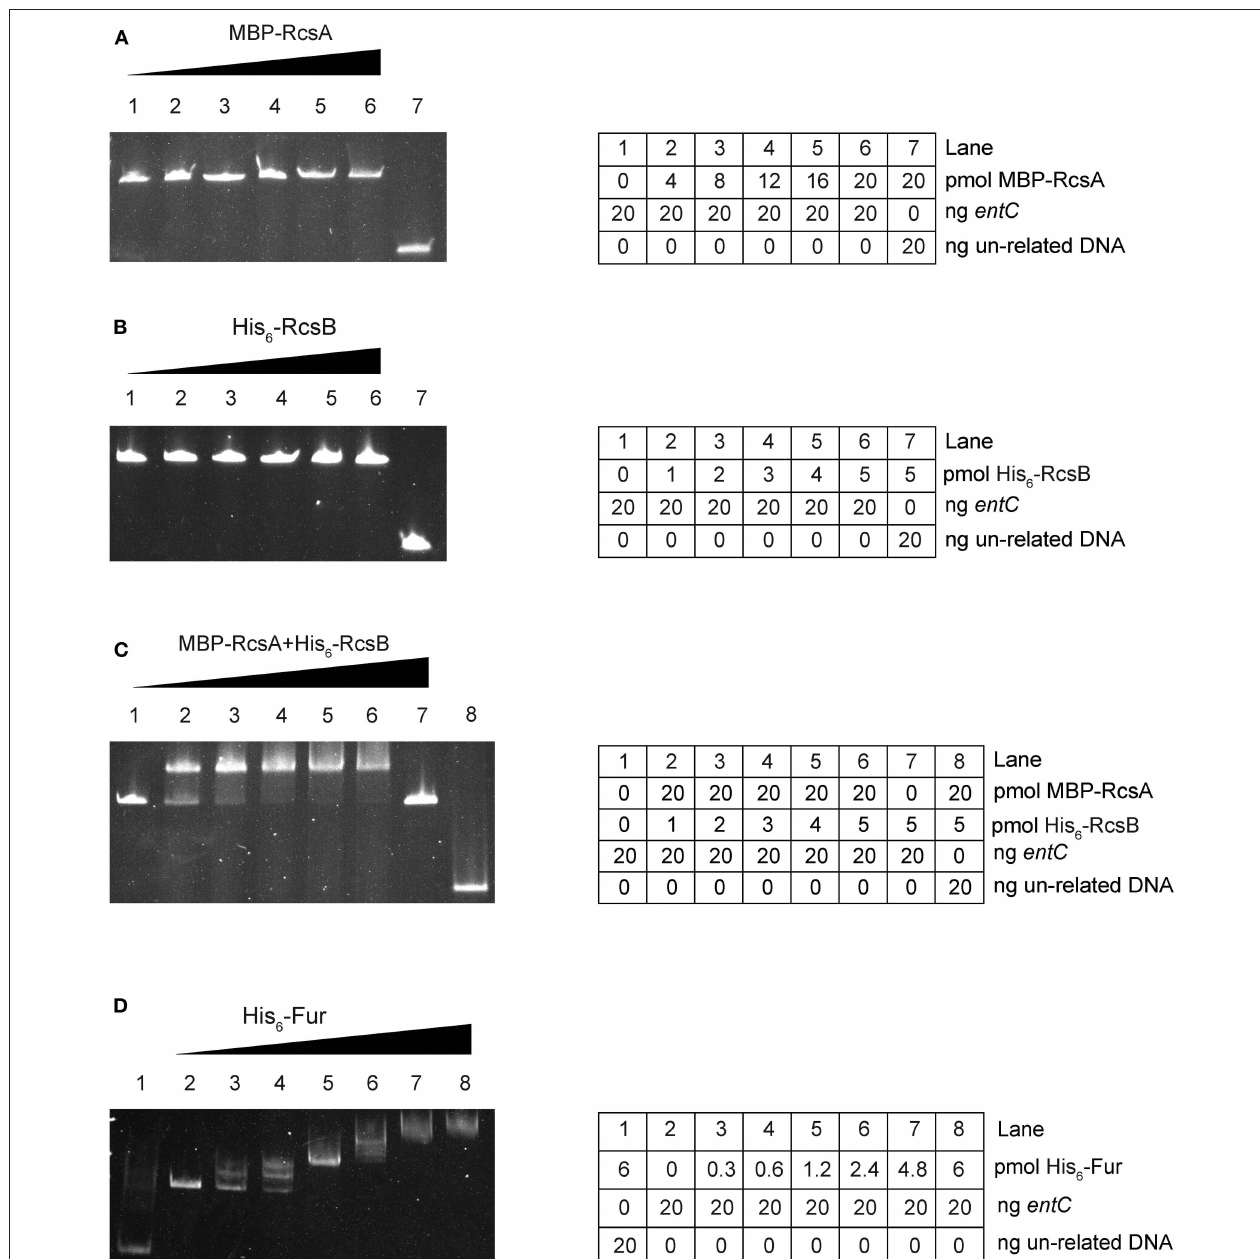
FIGURE 4 | RcsAB and Fur bind the entC promoter. The DNA binding capacities were evaluated by EMSAs. The promoter DNA fragments of entC were incubated with increasing amounts of purified MBP-RcsA (A) , His 6 -RcsB (B) , His 6 -RcsB mixed with MBP-RcsA (C) , and His 6 -Fur (D) and then subjected to polyacrylamide gel